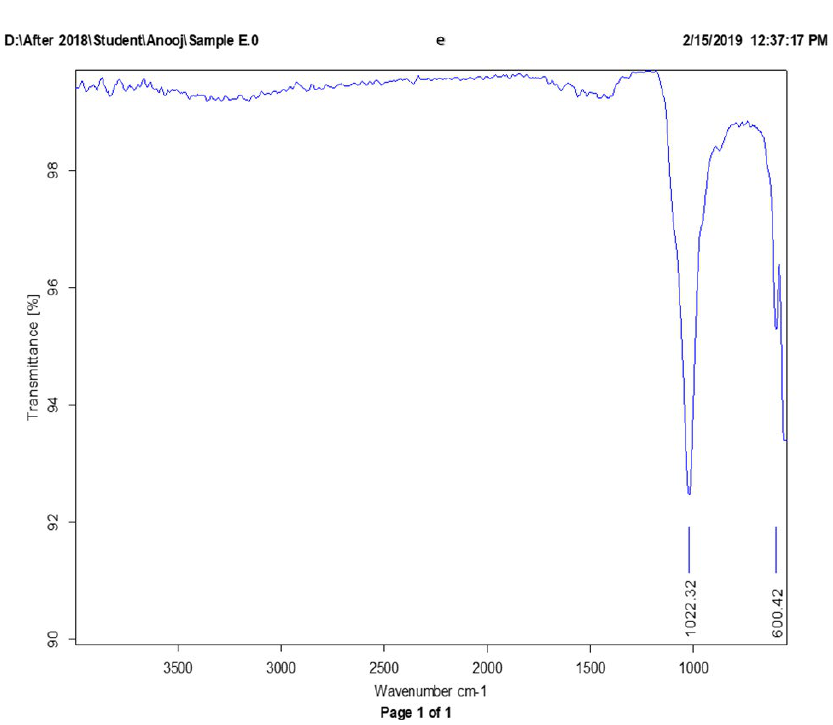
Fig. 4. (a to e). FTIR spectra of different ratios of chitosan/hydroxyapatite nanocomposite (CS/HA) a. Chitosan/ Hydroxyapatite ratio: 100/5, b. Chitosan/ Hydroxyapatite ratio: 100/10, c. Chitosan/ Hydroxyapatite ratio: 80/20, d. Chitosan/ Hydroxyapatite ratio: 50/50, e. Chitosan/ Hydroxyapatite ratio